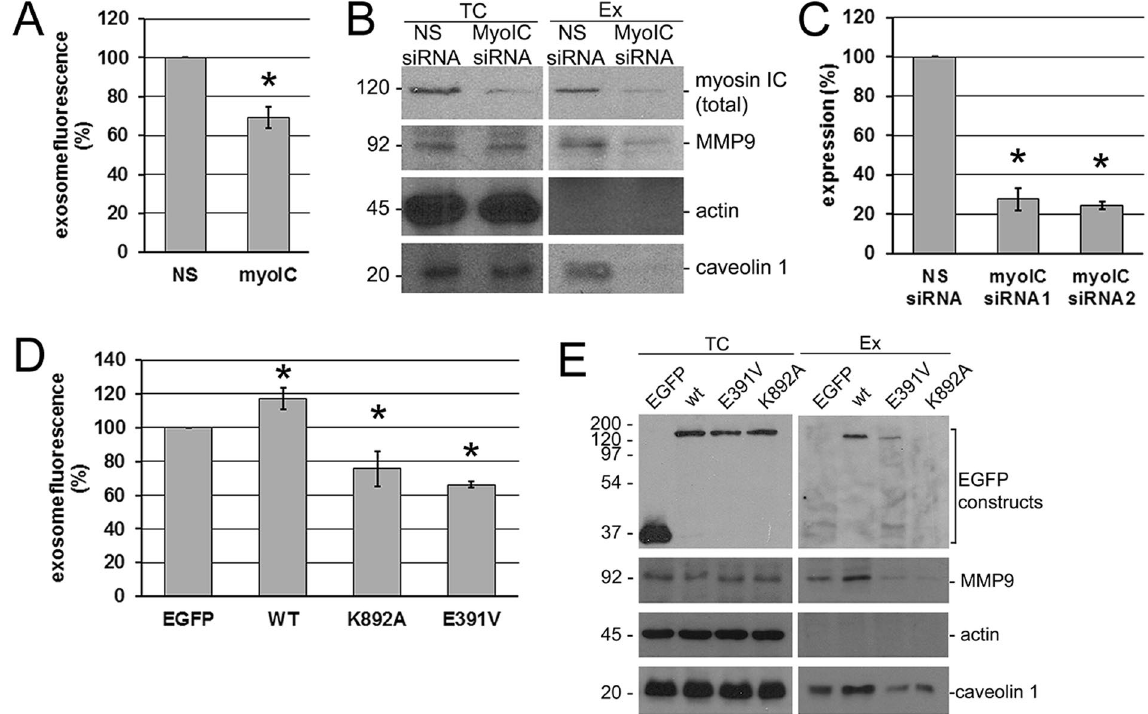
Figure 2. Effects of myosin IC and isoform A on exosome and metalloprotease secretion by prostate cancer cells. ( A ) Fluorescence of the secreted exosomal fraction (stained with membrane dye Vybrant DiI) from PC3 cells transfected with nonspecific ( NS ) and myosin IC-targeted ( myoIC ) siRNA. Data were normalized to the control (nonspecific siRNA treatment) in each experiment. N = 8 cell cultures per group. Experiment was repeated 4 times. Error bar: 95% c.i. on the mean. ( B ). Western blot analysis of total cell ( TC ) extract and secreted exosomes ( Ex ) from the siRNA knockdown experiments. ( C ) Quantification of the knockdown. N = 2 cell cultures per group. Experiment was repeated 2 times. Error bar: 95% c.i. on the mean. Two different sequences were targeted by siRNA 1 and 2; siRNA 1 was used in all other experiments shown. * Significant (p < 0.0001) deviations from the control. ( D ) Fluorescence of the secreted exosomal fraction measured as in A , from PC3 cells transfected with EGFP fusion constructs of myosin IC isoform A. EGFP , control transfection with EGFP alone. WT , wild-type isoform A. K892A , lipid-domain substitution. E391V , motor-domain substitution. Data presentation as in ( A ). N = 5 cell cultures per group. Experiment repeated 5 times. Each p-value in pairwise comparisons with the control is < 0.0001 ( * ), and all null hypotheses are rejected at familywise significance level 0.05 if regarded as a multiple comparison using the Holm-Bonferroni correction. ( E ) Western blot analysis of total cell ( TC ) extract and secreted exosomes ( Ex ) from the EGFP fusion